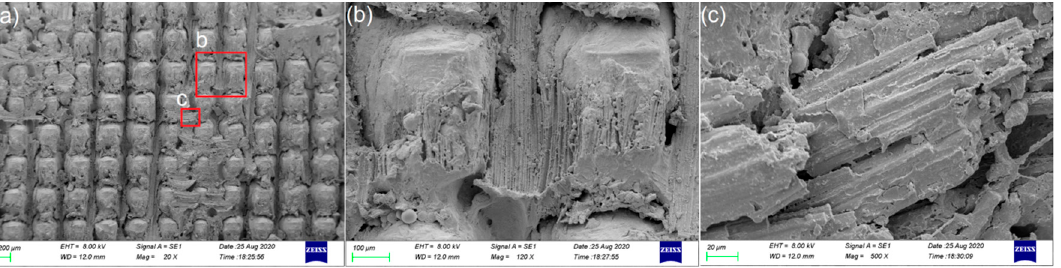
Figure 9. The morphology of fractured Ti6Al4V surfaces with 0°/90° grid patterns pre-textured on the Ti6Al4V surface. ( a ) SEM image showing the morphology of the fractured Ti6Al4V surface. ( b ) The residual PEEK resins in local area of the fractured Ti6Al4V surface. ( c ) The carbon fibers ob- served on the local fracture surface.